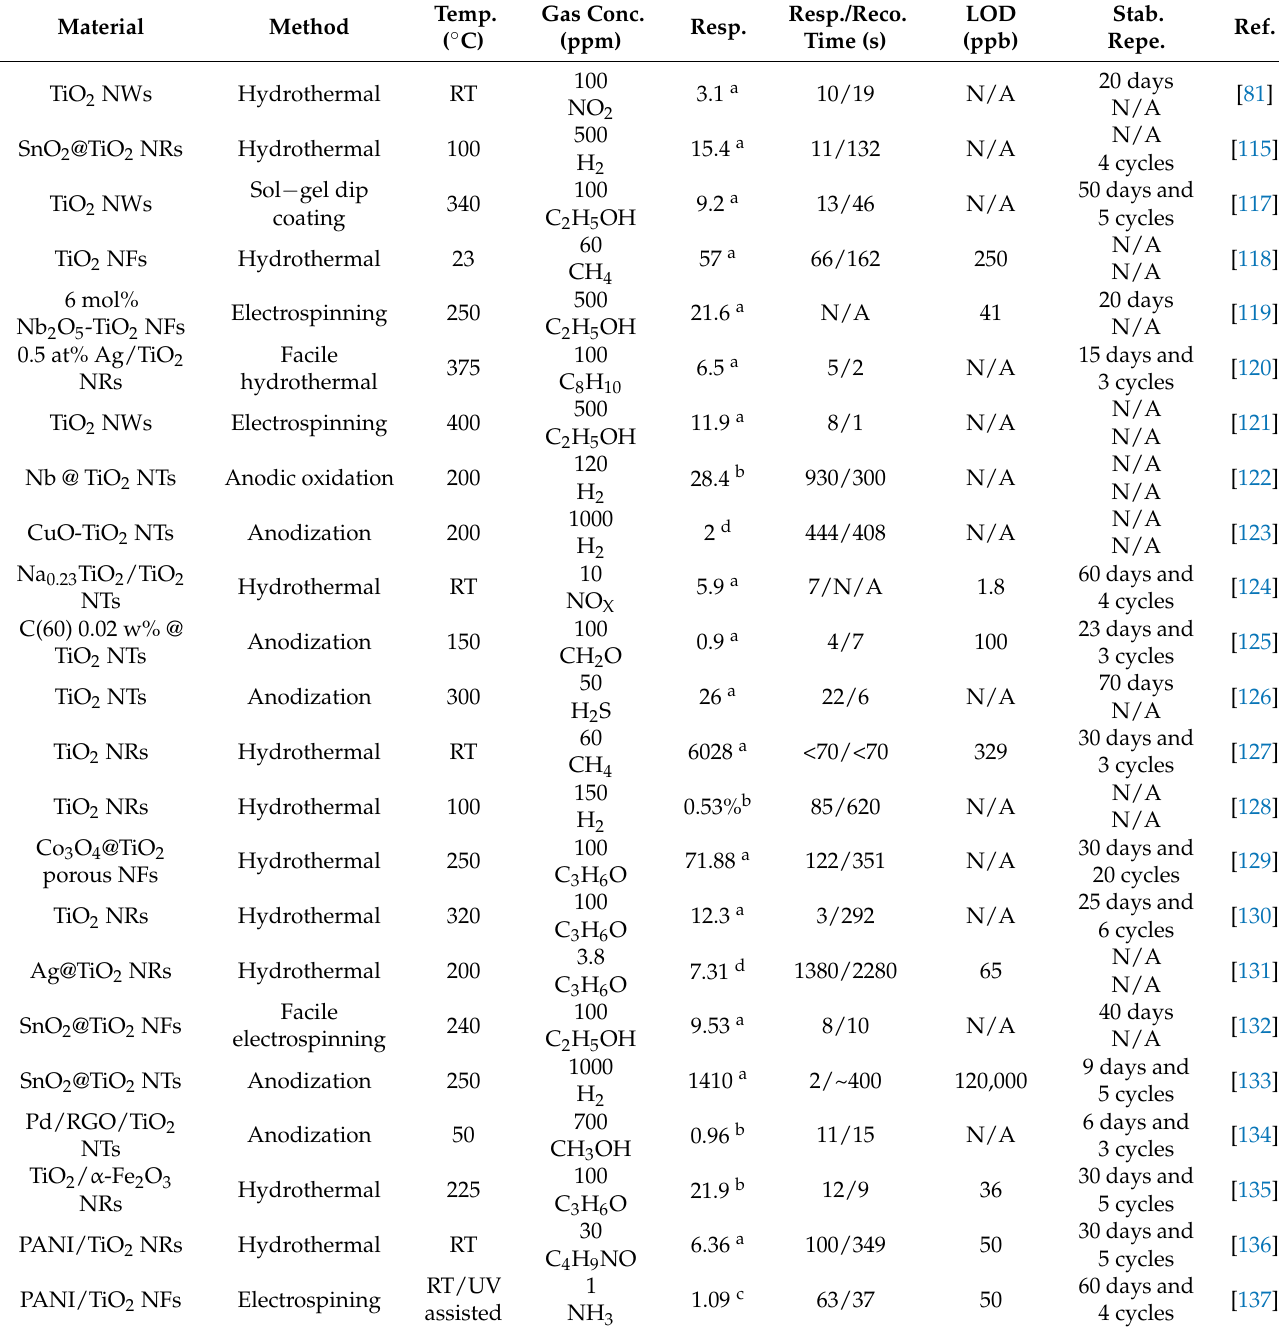
Table 5. Gas-sensing functionality of 1D TiO 2